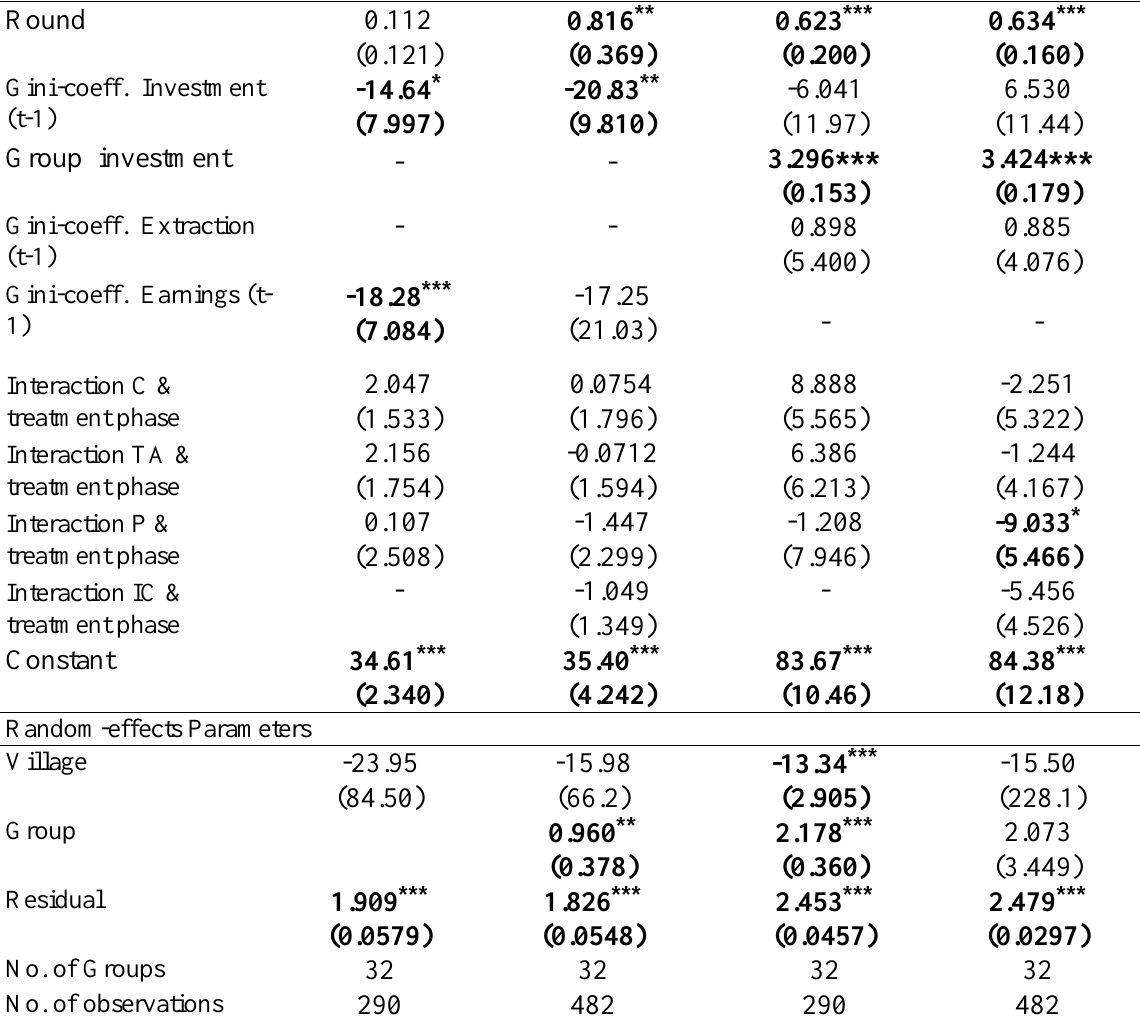
Table A4.5. Tobit models explaining the decision to initiate treatment against other